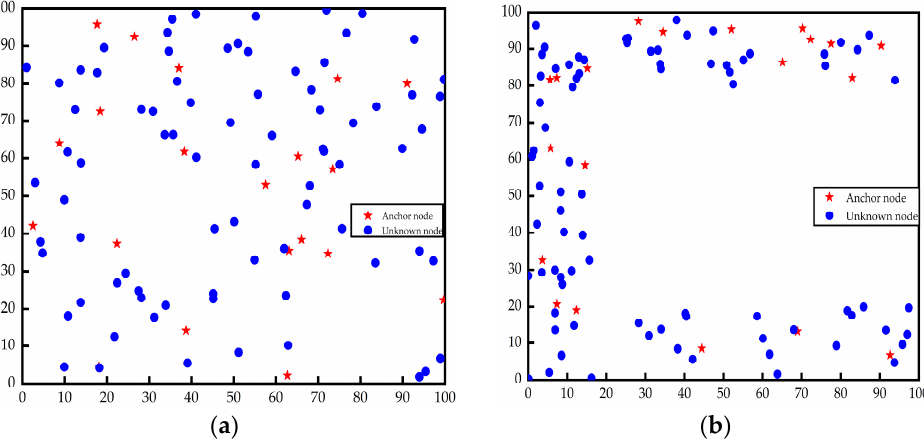
Figure 3. Node distribution diagrams: ( a ) square random topology; ( b ) C-shaped random topology.